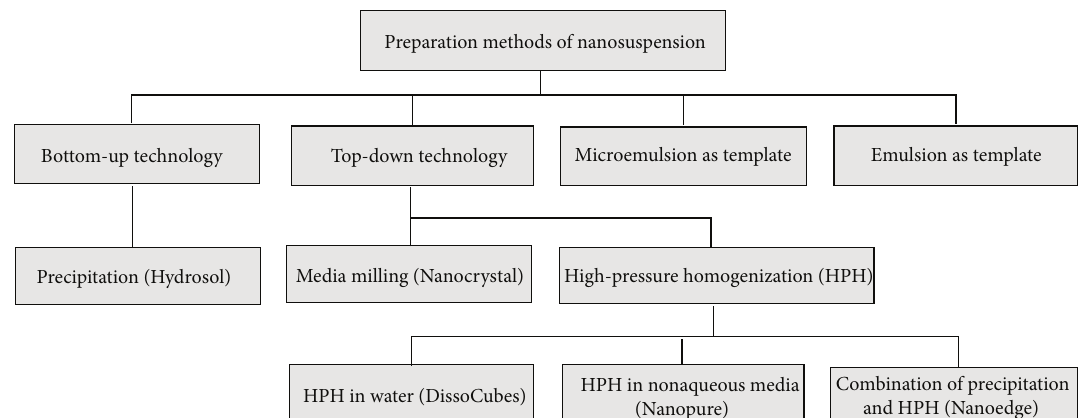
Figure 2: Schematic diagram of preparation methods of nanosuspension.